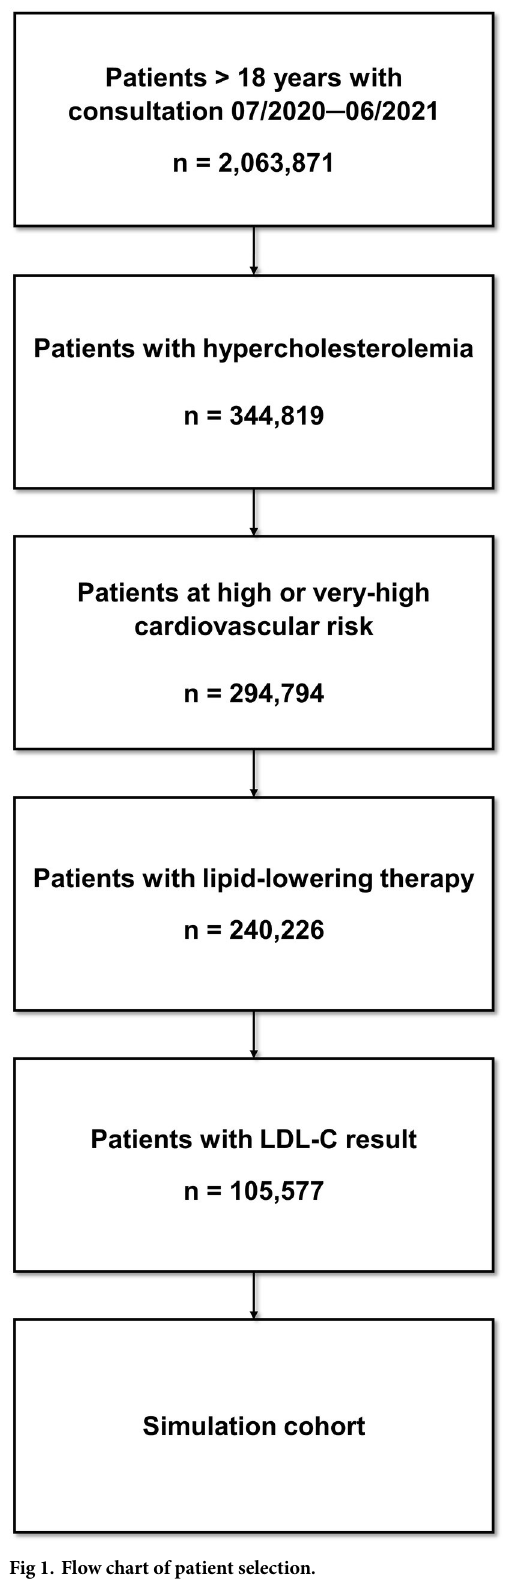
Fig 1. Flow chart of patient